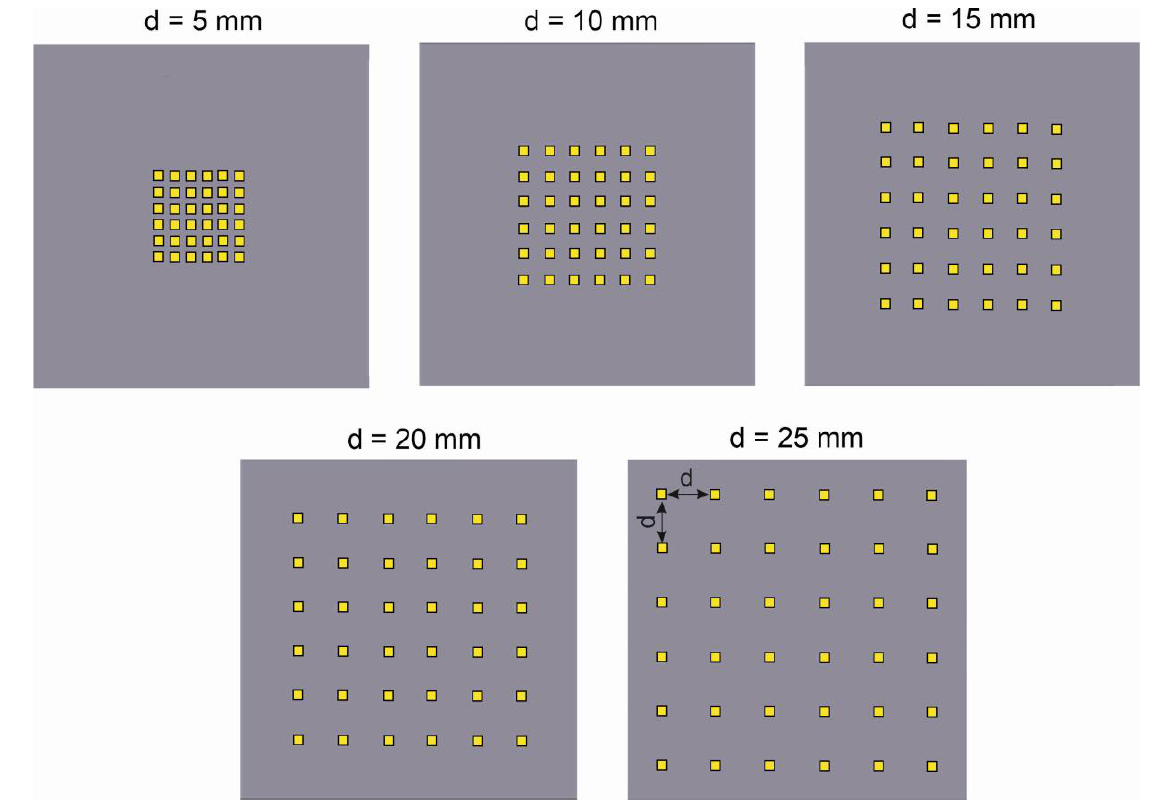
maximum junction temperature T j of the light source located in the center of the panel was T j = 118.2 °C. Figure 12. 6 × 6 LED panel with variable distance d between installed LEDs. Figure 12. 6 × 6 LED panel with variable distance d between installed LEDs.